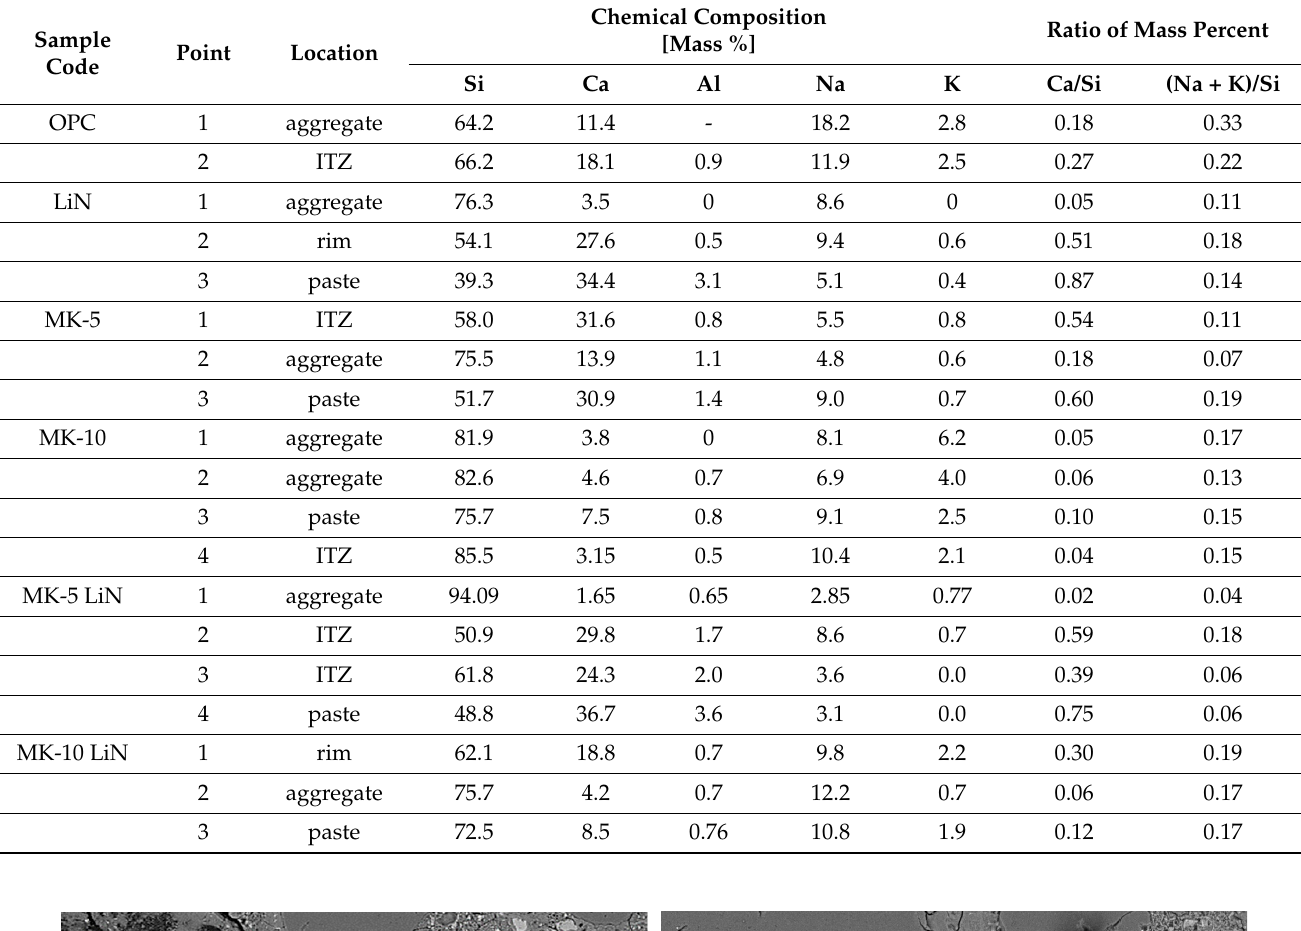
Table 4. Composition of potassium-sodium-calcium silicate gels obtained in the EDS analysis.